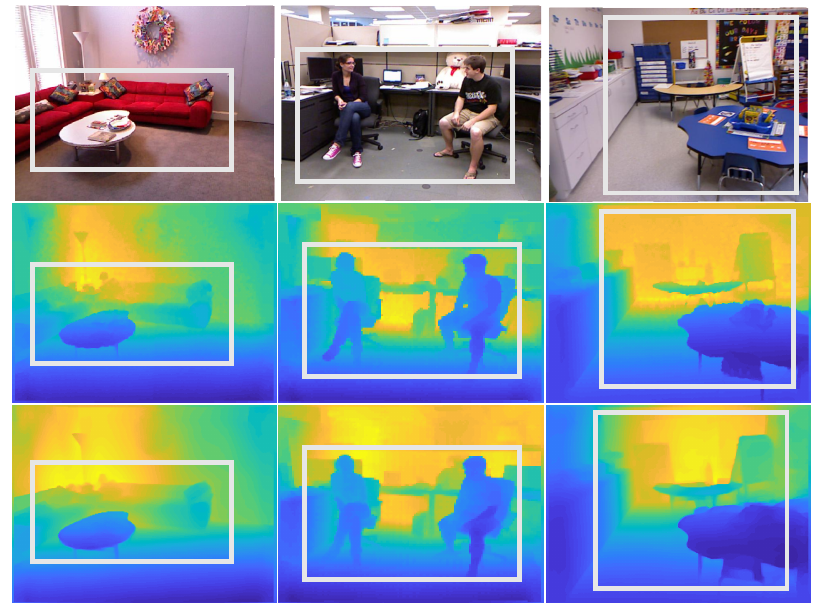
Figure 7. (row 1) Input images, (row 2) ground-truth depth, and (row 3) resulting depth images with the NYU Depth-v2 dataset.